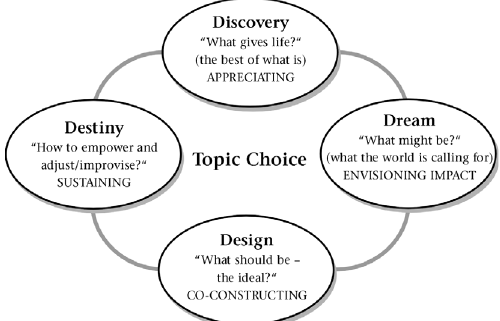
Figure 2: The Appreciative Inquiry 4-D Cycle (Cooperrider, Whitney, & Stavros, 2003, p.